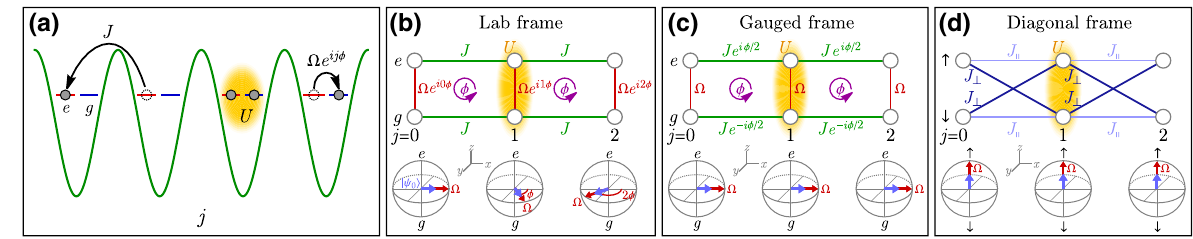
FIG. 1. (a) Schematic of the driven optical lattice system for n = 2 internal spin states labeled by m ∈ { e , g } . (b) Effective L × 2 ladder configuration realized by the system in the lab frame, where the spin-orbit coupling phase e ij φ appears in the laser drive Hamiltonian that couples the internal states. Each plaquette in the two-leg ladder is pierced by a flux φ . The Bloch spheres at the bottom show the initial product state | ψ 0 (cid:4) considered in this paper with blue arrows, treating each atom as a spin-1/2 degree of freedom assuming a filling fraction of one atom per site. The direction of the drive about which each spin rotates is shown in red. The initial state | ψ 0 (cid:4) is an eigenstate of the drive and points in the same direction. (c) Visualization of the system in the gauged frame, where the spin-orbit coupling phase is put into the tunneling matrix elements along the lattice direction j . (d) Visualization of the system in the diagonal frame where a further basis rotation diagonalizes the drive, defining dressed fermionic states ν ∈ {↑ , ↓} as the single-particle eigenstates of the drive with energies + (cid:2)/ 2, − (cid:2)/ 2, respectively. The flux enables both spin-conserving and spin-flipping tunneling with rates J (cid:7) = J cos (φ/ 2 ) and J ⊥ = J sin (φ/ 2 ) ,